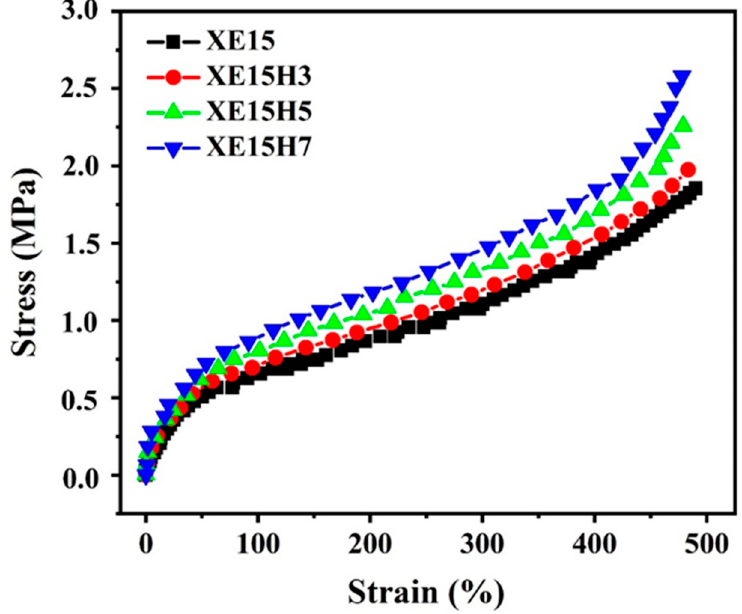
Figure 3. Uniaxial stress–strain behavior of XNBR/epoxy/XHNTs nanocomposites.